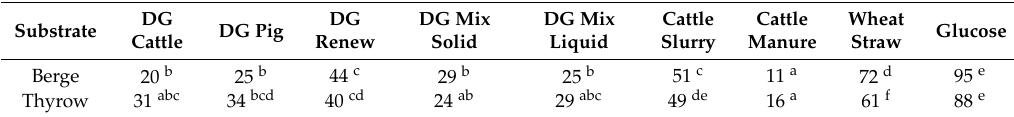
Table 5. Mineralized portion (%) of the weighed-in carbon after 178 days, depending on the two types of soil from Berge and Thyrow. Di ff erent letters within a row mark significant di ff erences between the treatments for each soil (Tukey’s HSD test, p ≤ 0.05, n =